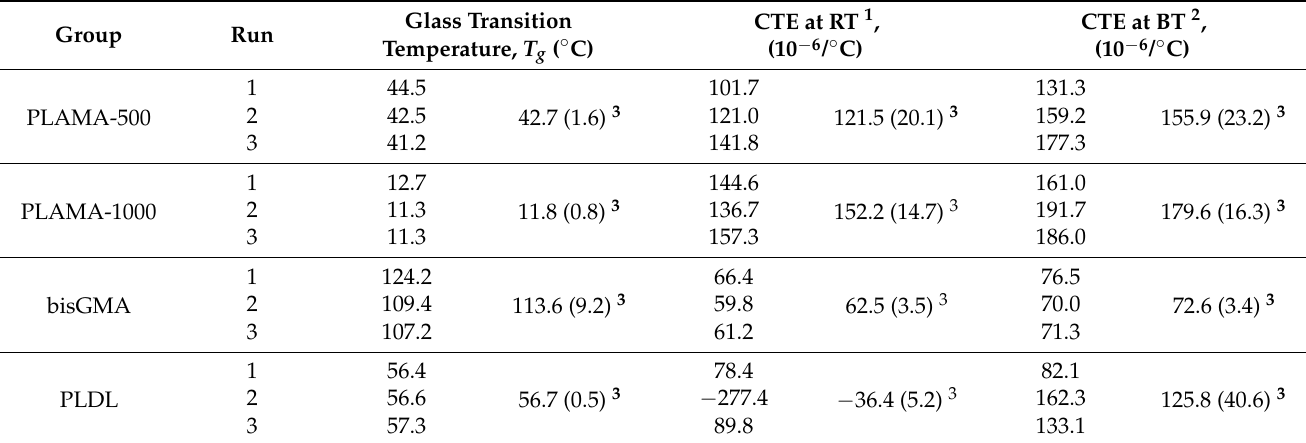
Figure 9. TMA thermograms for the three consecutive heating and cooling cycles in groups: PLAMA-500 ( A ), PLAMA-1000 ( B ), bisGMA ( C ), and PLDL ( D ). Table 5. Numerical results of the multicyclic thermomechanical analysis